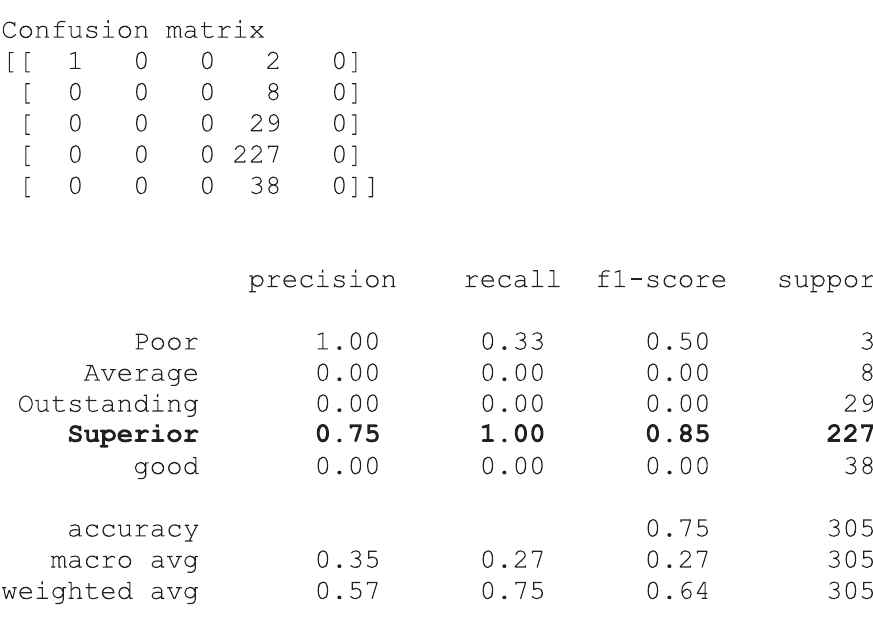
Figure 9: Logistic regression confusion matrix and accuracy results.